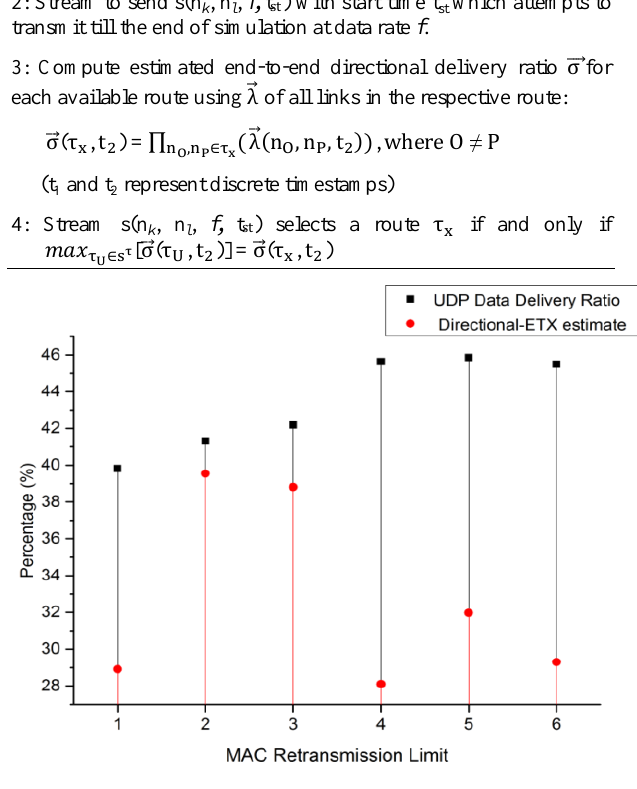
Figure 2: Data Delivery Ratio v/s Directional ETX